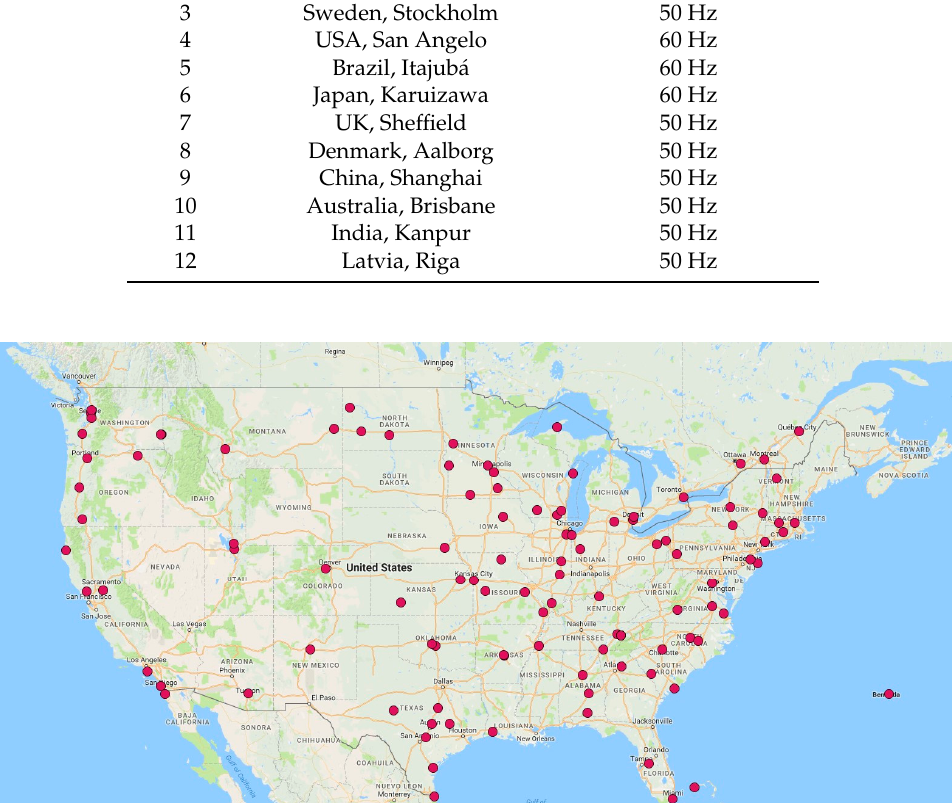
Figure 1. FNET/GridEye sensor deployment in North America. The red point shows the frequency disturbance recorder (FDR) location.